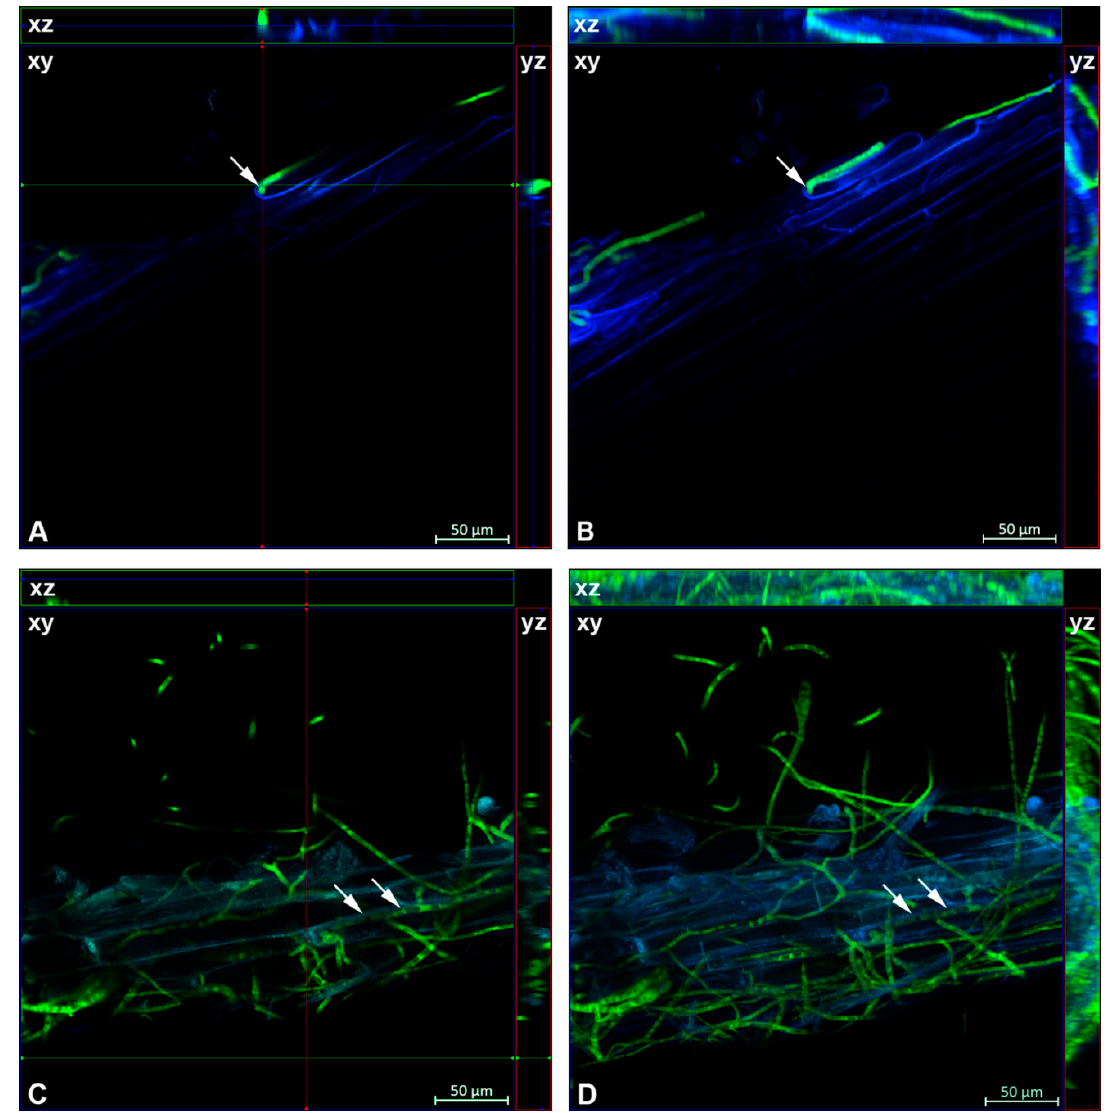
Figure 2. Orthogonal projections obtained on a Zeiss 880 confocal microscope. ( A , B ) Maize roots inoculated with Ct0861-GFP. ( C , D ) Tomato roots inoculated with Ct0861-GFP. ( A ) Projection at position z = 13. ( B ) Maximum projection. ( C ) Projection at position z = 7. ( D ) Maximum projection. Green fluorescence detects Ct0861-GFP hyphae. The blue signal corresponds to the autofluorescence of the cell walls. Arrows show the position of the hyphae inside the cells.